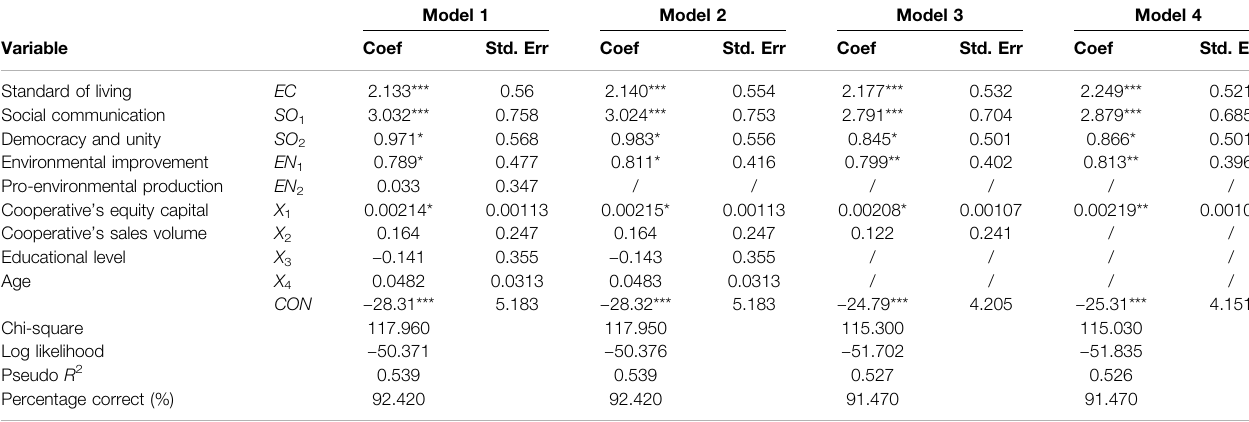
TABLE 2 | Parameter estimates for the binary logit models for farmer ’ s satisfaction and assessment of cooperative